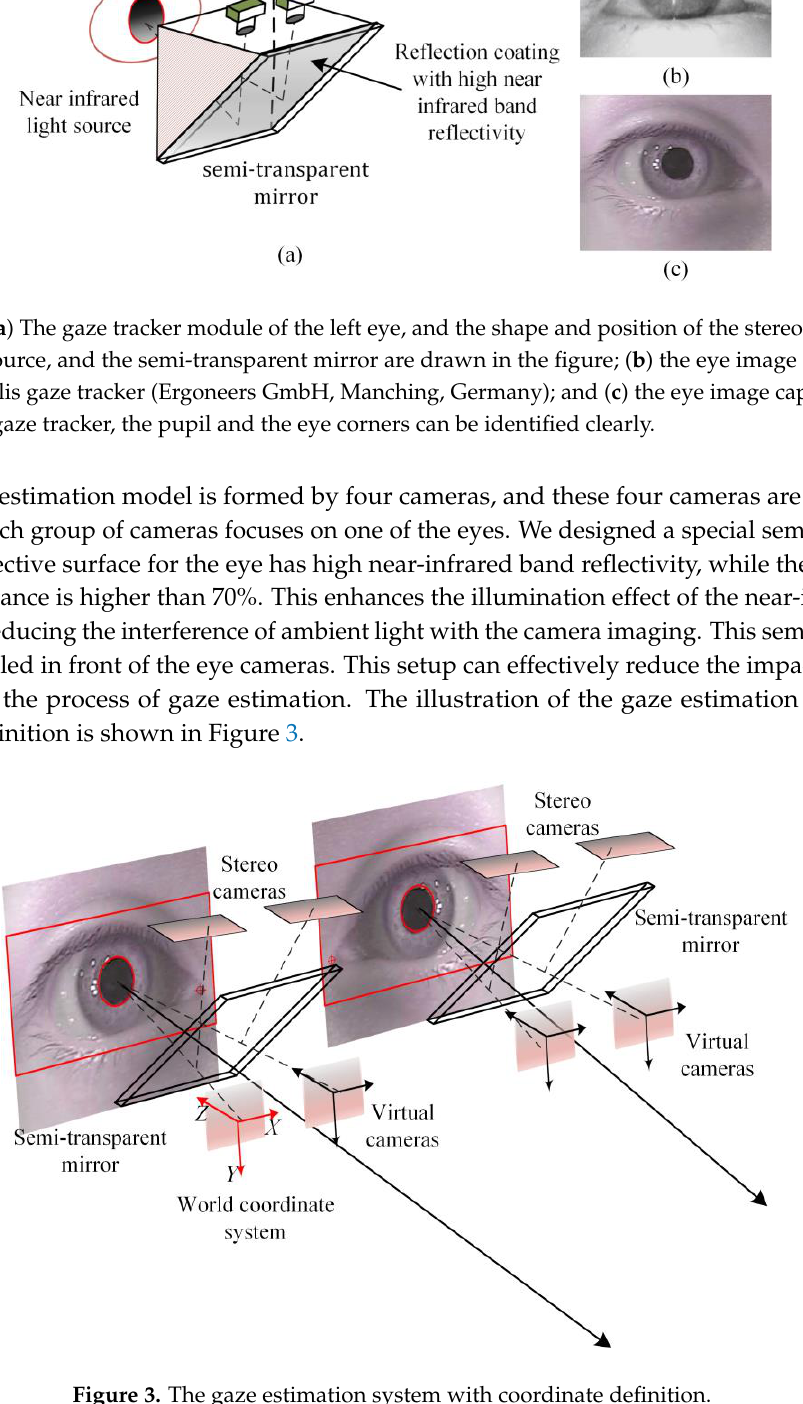
Figure 3. The gaze estimation system with coordinate definition.